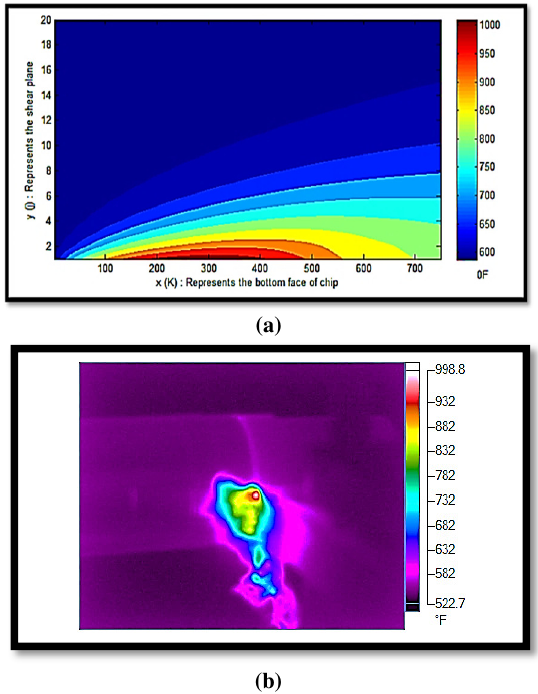
Fig. 15. Temperature fields of machining with spindle speed (500r.p.m), feed (0.1mm/rev), depth (0.5mm), (a) temperature distribution simulation, (b) experimental measuring of temperature using